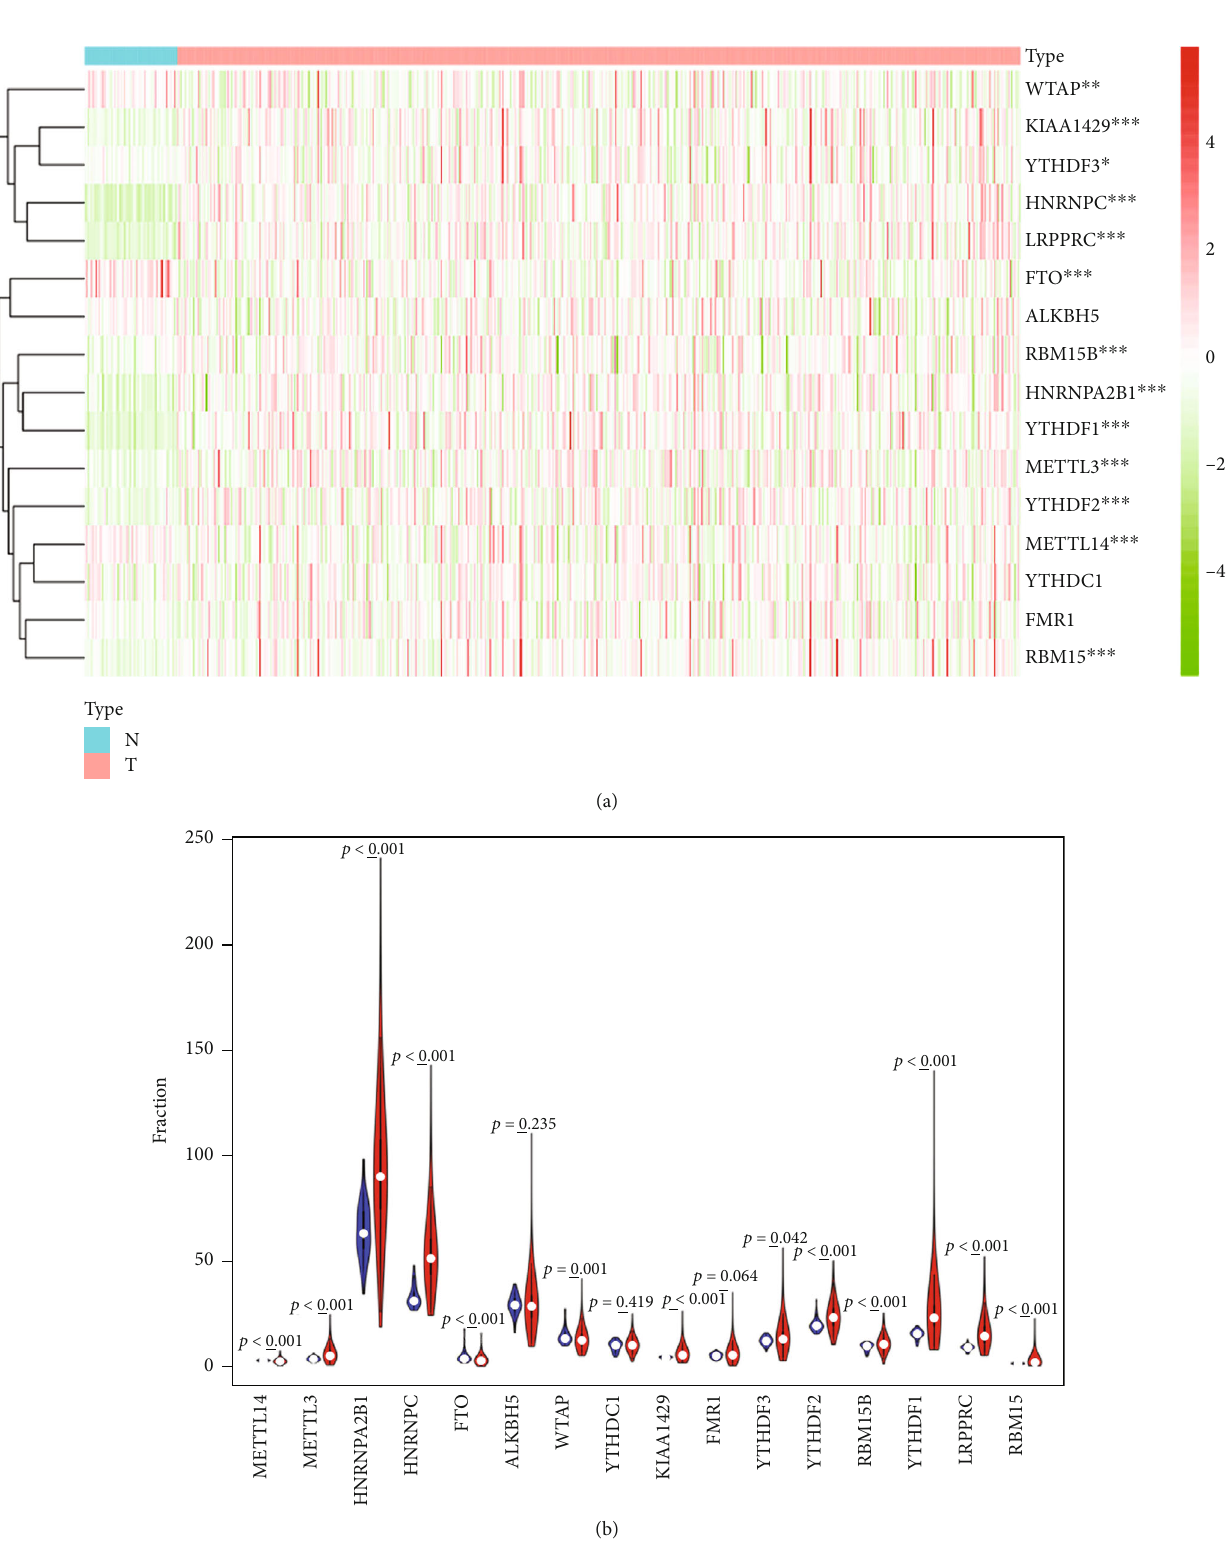
Figure 1: The heat map (a) and violin diagram (b) of di ff erential expression of M6A-related genes in normal samples and lung adenocarcinoma samples. The color from green to red shows a trend from low expression to high expression. Red represents high expression, and blue represents low expression. P < 0 : 05 as the statistical cuto ff